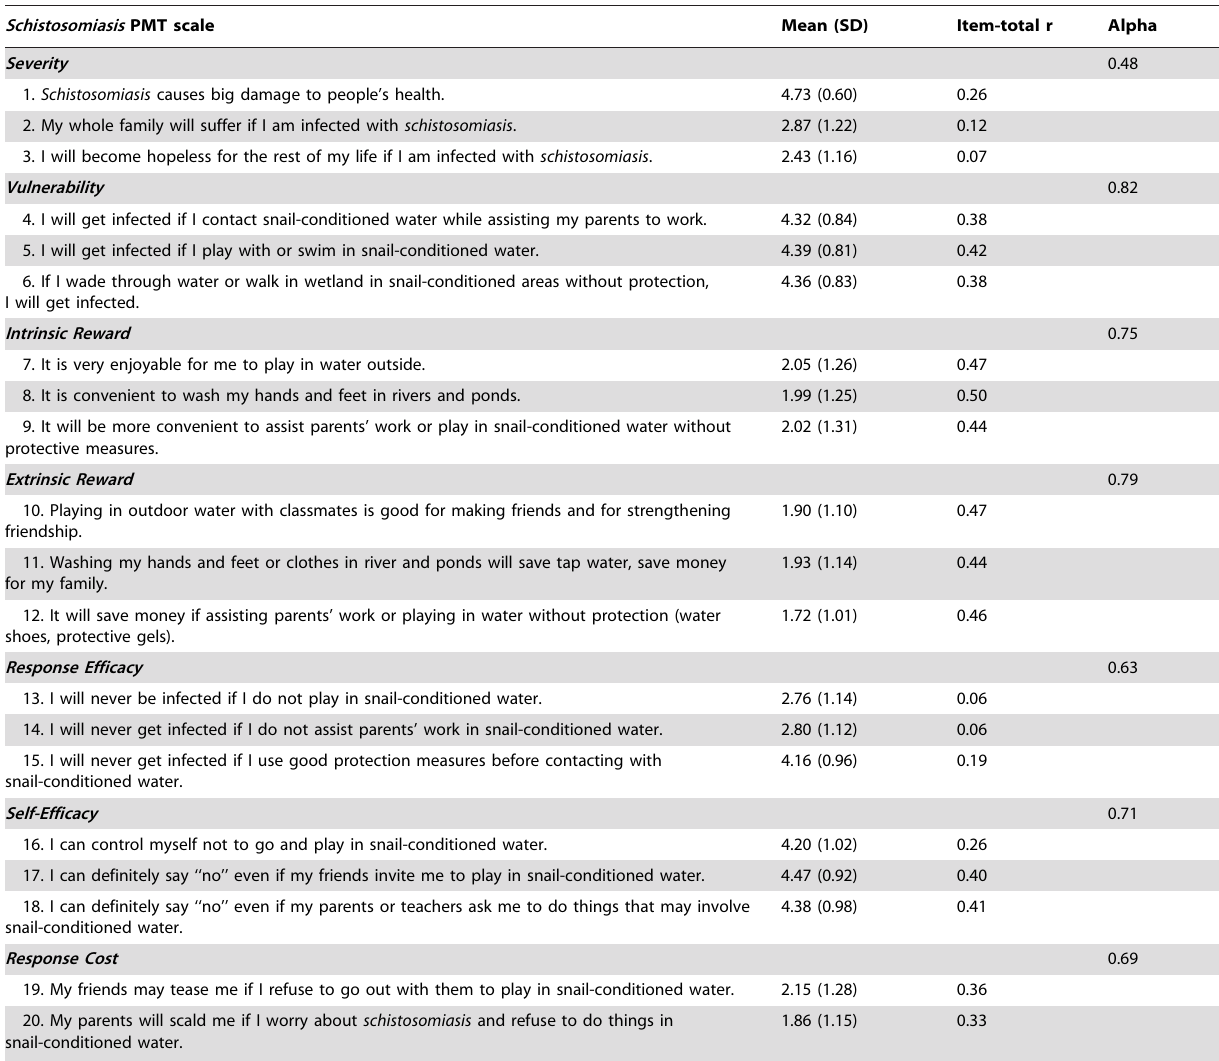
Schistosomiasis PMT